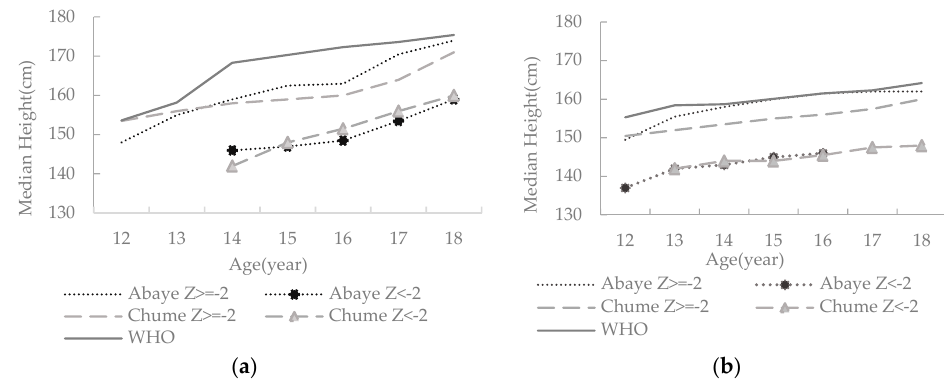
Figure 3. Height of stunted and non-stunted adolescent ( a ) boys and ( b ) girls by age. The overall prevalence of thinness 30 (12.8%) in the study areas was high. Nevertheless, it was significantly higher in Chume than in Abaye ( χ 2 = 22.726, p = 0.000) and for boys compared to girls ( χ 2 = 5.506, p = 0.019). We observed severe thinness for 4 (7.5%) boys and 3 (5.5%) girls from Chume, while none of the adolescents from Abaye were severely thin (Figure 2b). The prevalence of thinness was 1 (1.6%) and 9 (16.4%) for the girls and 3 (4.7%) and 17 (32.1%) for the boys in Abaye and Chume,